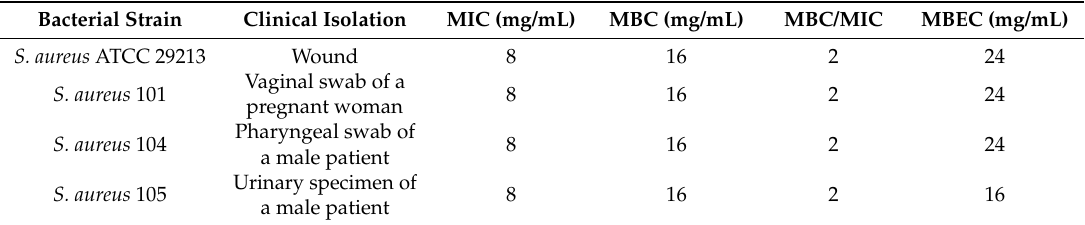
Table 6. The evaluation of the minimum inhibitory concentration (MIC), minimum bactericidal concentration (MBC), and minimum biofilm eradication concentration (MBEC) of the hemp EO against Staphylococcus aureus. Data are presented as the mean of three replicates of three independent experiments. ATCC—American Type Culture Collection.